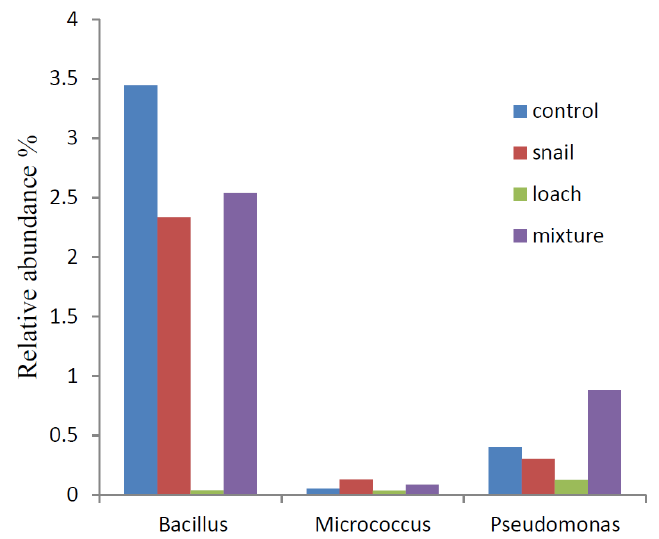
Figure 6. Relative bundances of the Proteobacteria groups.